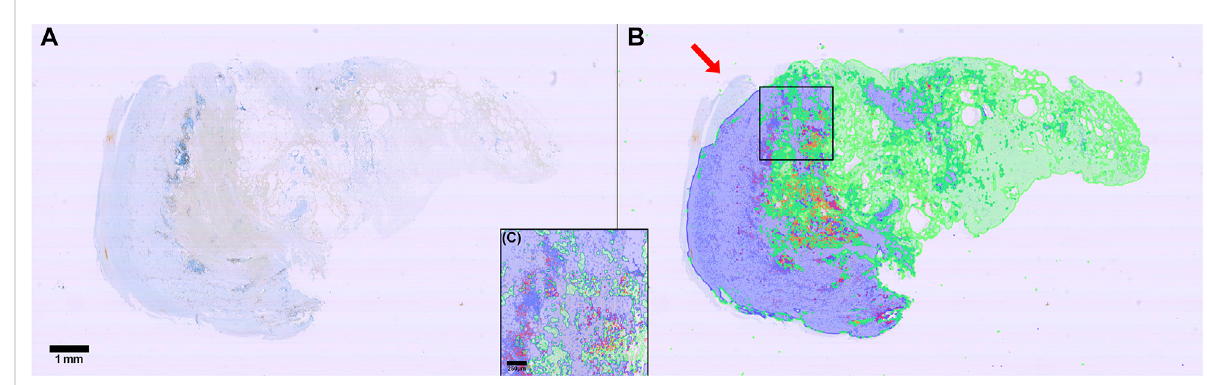
FIGURE 9 Illustration of cell detection using antiCD8 immunostaining. (A) Raw immunostained image (DAB and hematoxylin stained). (B) Image in A with overlaid zone predictions (Blue: Zone 1 border. Green: Zone 2 border. Red: Thrombus) and all cell detections (Light blue: Hematoxylin stained nucleusinCD8negativecell.Lightred:Hematoxylin-stainednucleusinCD8positivecell). (C) zoominofsquarein (B) .Scalebaris1 mm (A,B) 250µm (C) Arrow: part of the tissue that we can assume would be zone 1. Please refer to the discussion for